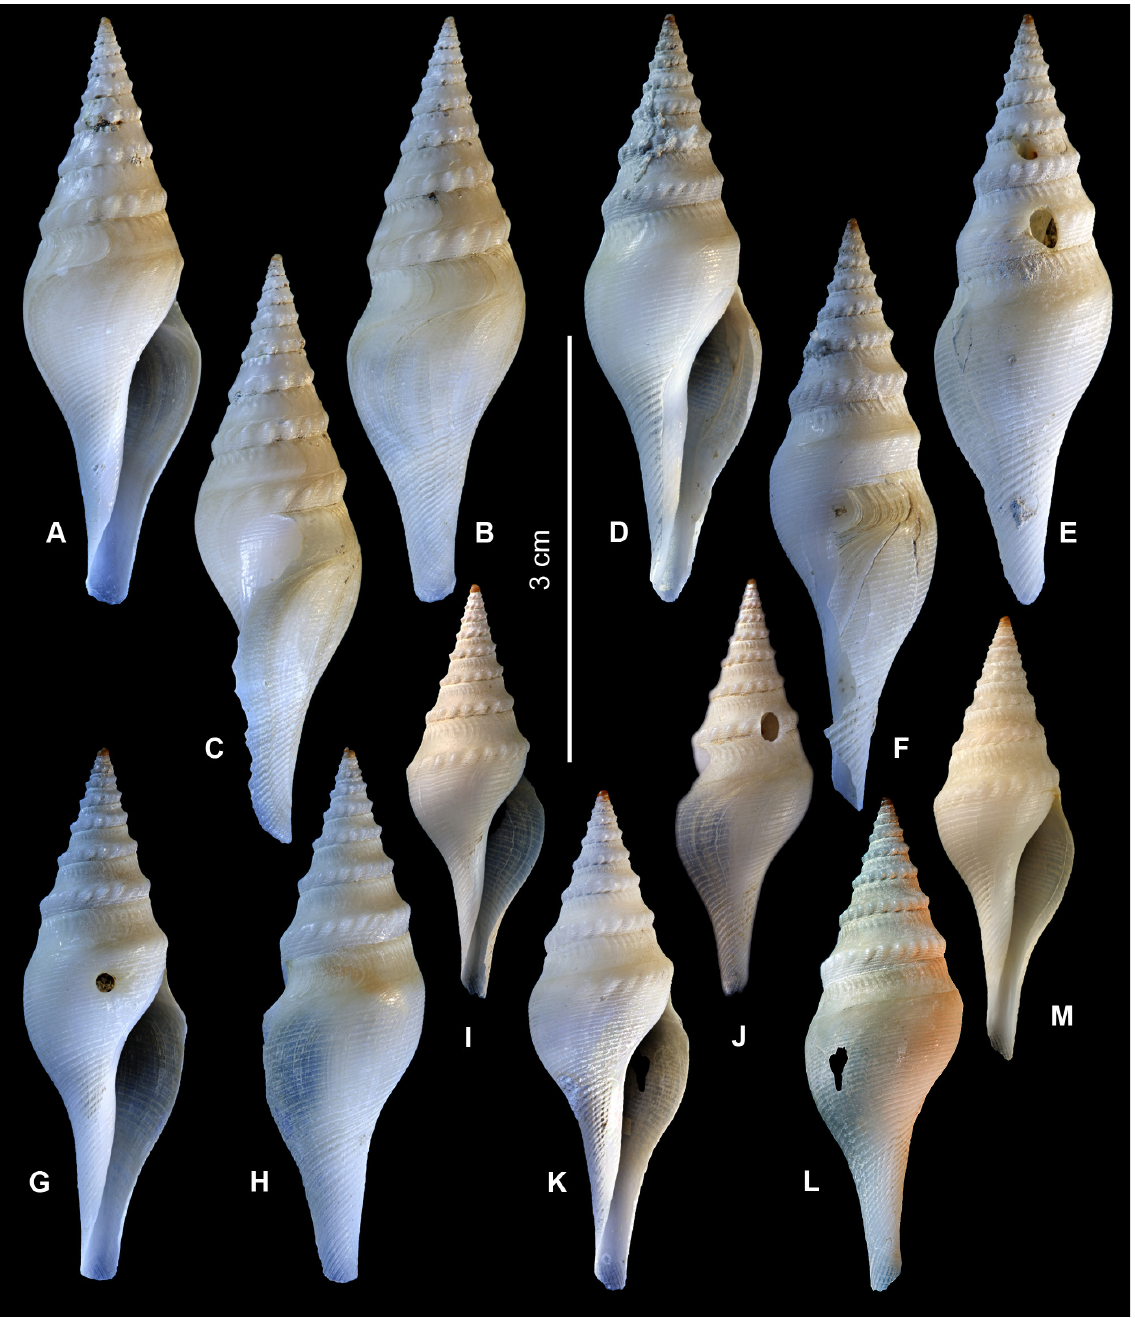
Fig. 10. A–C . Sibogasyrinx maximei sp. nov., Solomon Sea, holotype, MNHN-IM-2013-45883, SL 41.6 mm. D–M . Sibogasyrinx clausura sp. nov. D–F . Solomon Islands, holotype, MNHN- IM-2013-48256, SL 41.4 mm. G–H . Coral Sea, Coriolis Bank, MNHN-IM-2013-48167, SL 37.9 mm. I–J . Solomon Islands, MNHN-IM-2009-16763, SL 29.6 mm. K–L . Coral Sea, Coriolis Bank, MNHN- IM-2013-48244, SL 35.6 mm. M . Coral Sea, Coriolis Bank, MNHN-IM-2013-48144, SL 31.7 mm. All shells to same